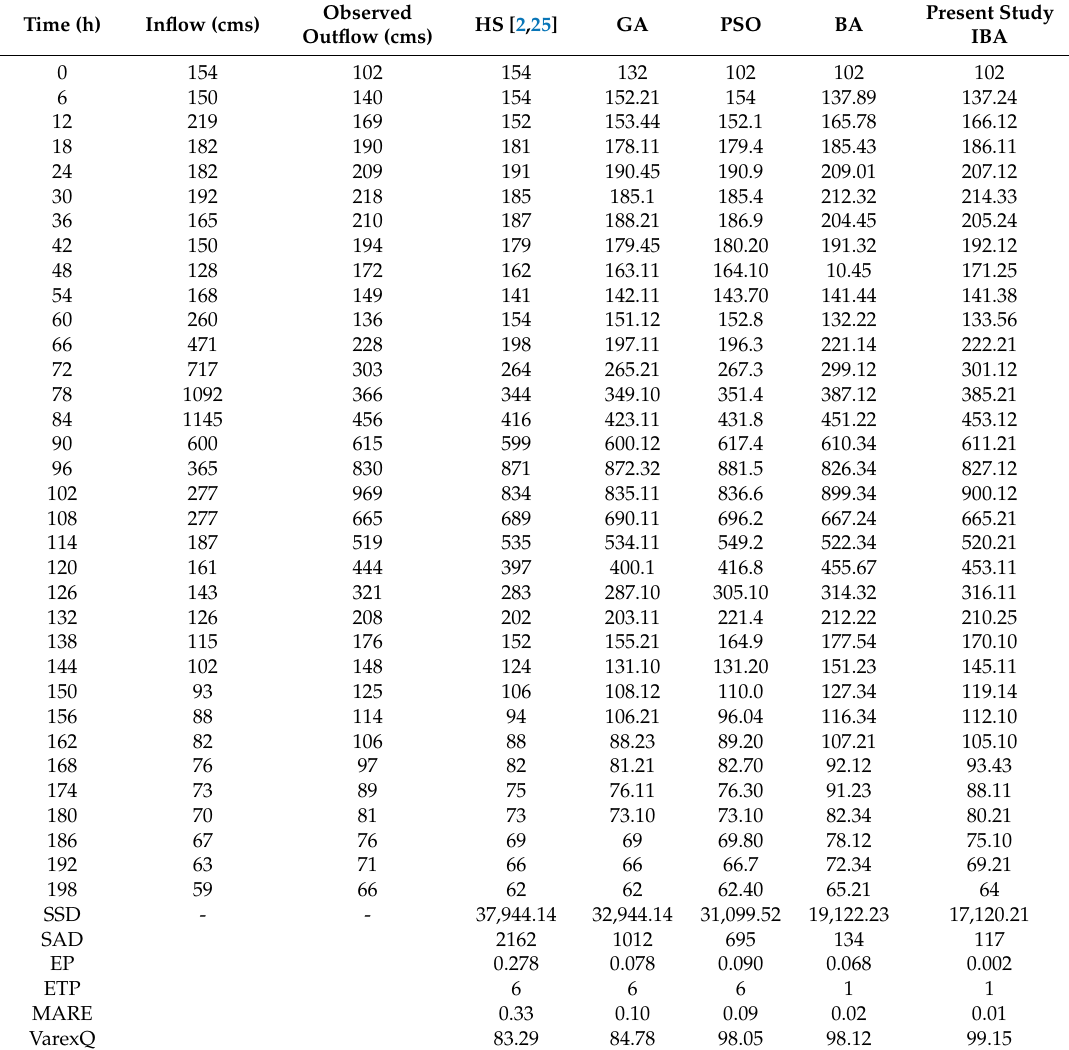
Figure 5. The first and second scenario for calibration of model.